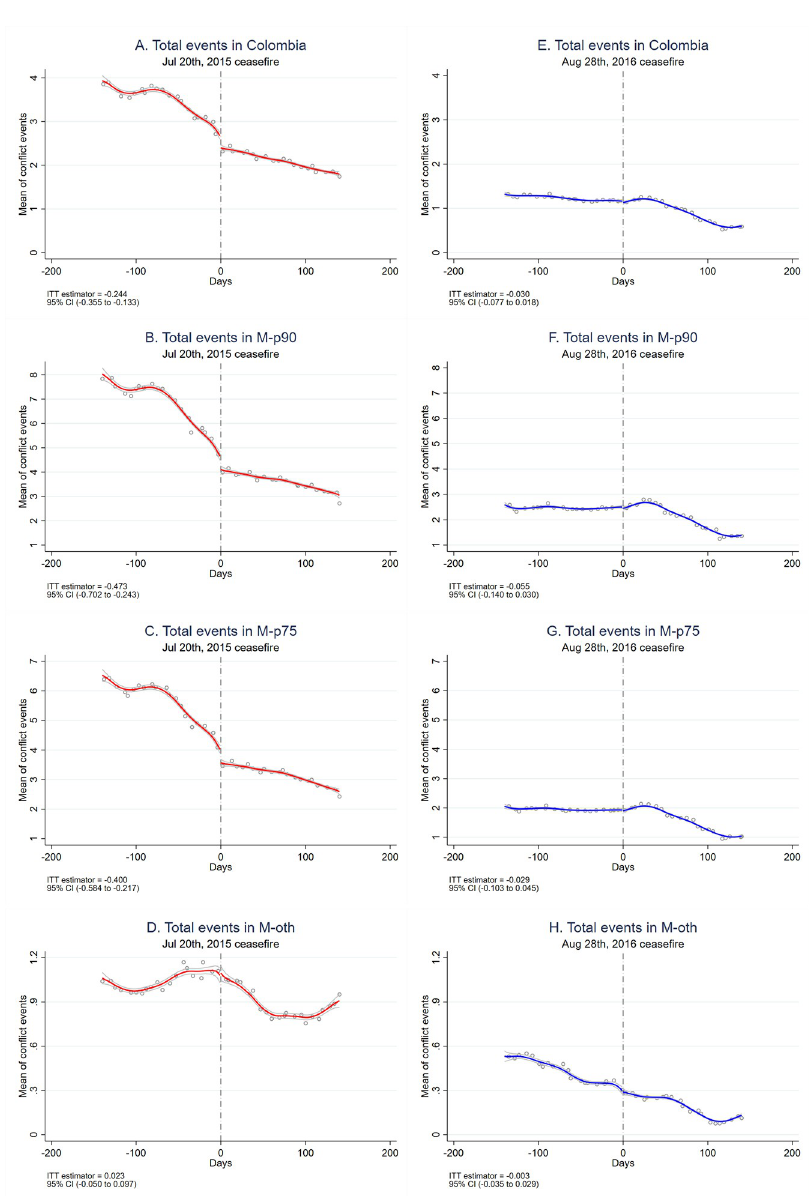
Fig 2. Association between the July 20, 2015 and August 28, 2016 cease-fires and the exposure to total conflict events during pregnancy: Colombia and categories of municipalities (RD plots). Association between the July 20, 2015 and August 28, 2016 cease-fires and the exposure to total conflict events during pregnancy (i.e., events related to any armed group). Local linear regressions and 95% confidence interval. A, B, C, and D show the estimates of the July 20, 2015 cease-fire (red lines). E, F, G, and H show the estimates of the August 28, 2016 cease-fire (blue lines). A and E include women from all municipalities in Colombia. B and F only include women in M-p90 municipalities. C and G only include women in M-p75 municipalities. D and F only include women in M-other municipalities. We do not show graphs for women in M-zero municipalities as these women were not exposed to conflict events. M-p90: municipalities with total number of FARC-related violent events above the 90th percentile of the distribution of these events; M-p75: municipalities with total number of FARC-related events above the 75th percentile of the distribution of these events; M-zero: municipalities with no conflict event recorded during the entire 2000 to 2017 period (whether involving FARC or not); and M-other: municipalities that did not belong to any of the other 3 municipality groups. The results indicate that the July 20, 2015 cease-fire was associated with a statistically significant discontinuity in the number of conflict events only for women in M-p90 and M-p75 municipalities, while the August 28, 2016 cease-fire was not associated with in any statistically significant changes in exposure to conflict events for pregnant women. ITT estimates by RD analysis using local linear regression and optimal bandwidth of 56 days. 9 AU : AbbreviationlistshavebeencompiledforthoseusedthroughoutFigs 2 and 3 : Pleaseverifythatallentriesarecorrect : 5% CI, 95% confidence interval; FARC, Fuerzas Armadas Revolucionarias de Colombia; ITT, intention-to-treat; RD, regression discontinuity.